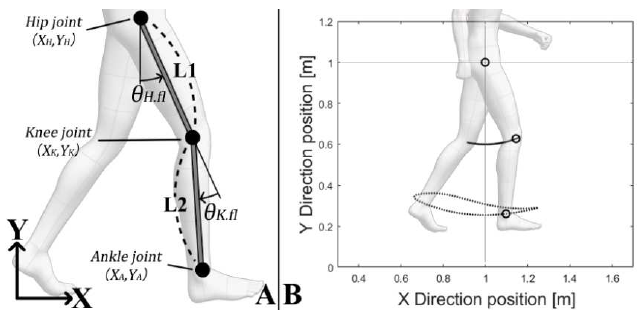
Figure 1. Joint angles converted into joint trajectories.